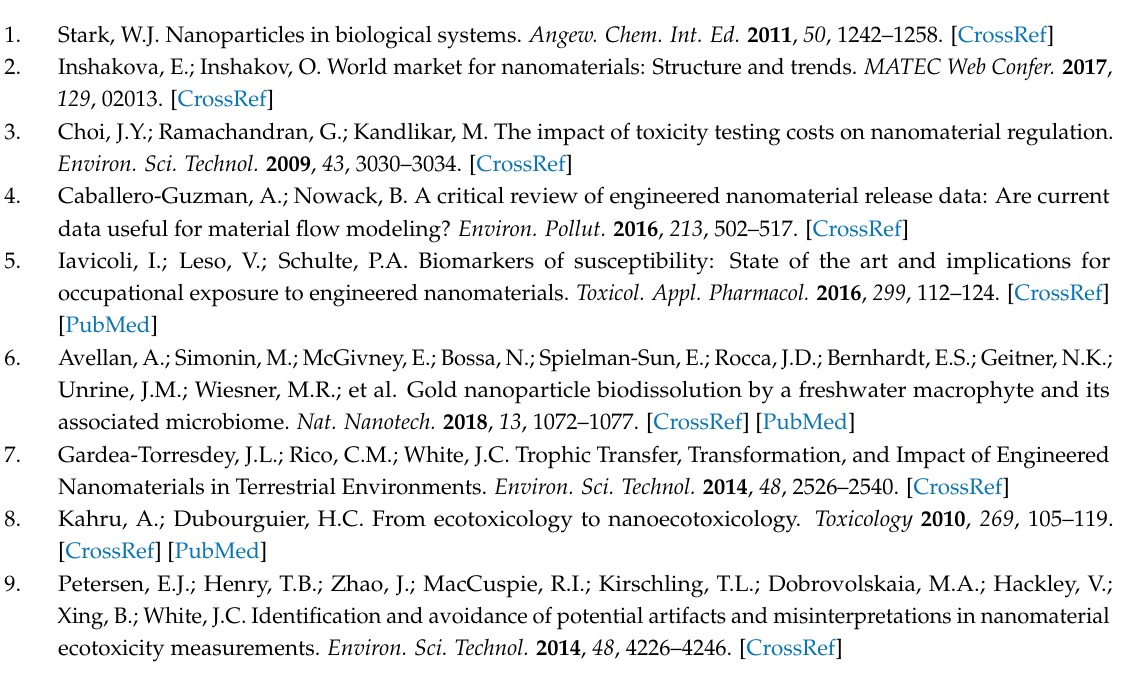
characteristics. Figure S1. Scatter plot representing the distribution of microarray expression data. Figure S2. Heatmap representing the comparison of the panel of 34 genes utilized for microarray validation by Real Time qPCR. Figure S3. Network of interaction of up-regulated genes derived from microarray analysis. Figure S4. Network of interaction of down-regulated genes derived from microarray analysis. Figure S5. Venn’s diagram representing the overlap between up- and down-regulated genes during CdS QDs’ exposure and Cd 2+ ions exposure. Table S1. List of up-regulated genes highlighted after the CdS QDs’ exposure in S. cerevisiae . Table S2. List of down-regulated genes highlighted after the CdS QDs’ exposure in S. cerevisiae . Table S3. Biological processes after CdS QDs’ exposure in S. cerevisiae . Table S4. Molecular functions after CdS QDs’ exposure in S. cerevisiae . Table S5. Cellular components after CdS QDs’ exposure in S. cerevisiae . Table S6. (KEGG) Biochemical pathways after CdS QDs’ exposure in S. cerevisiae . Table S7. Comparison of wild type strain versus sensitive and tolerant mutants. Table S8. Comparison of wild type strain and tolerant